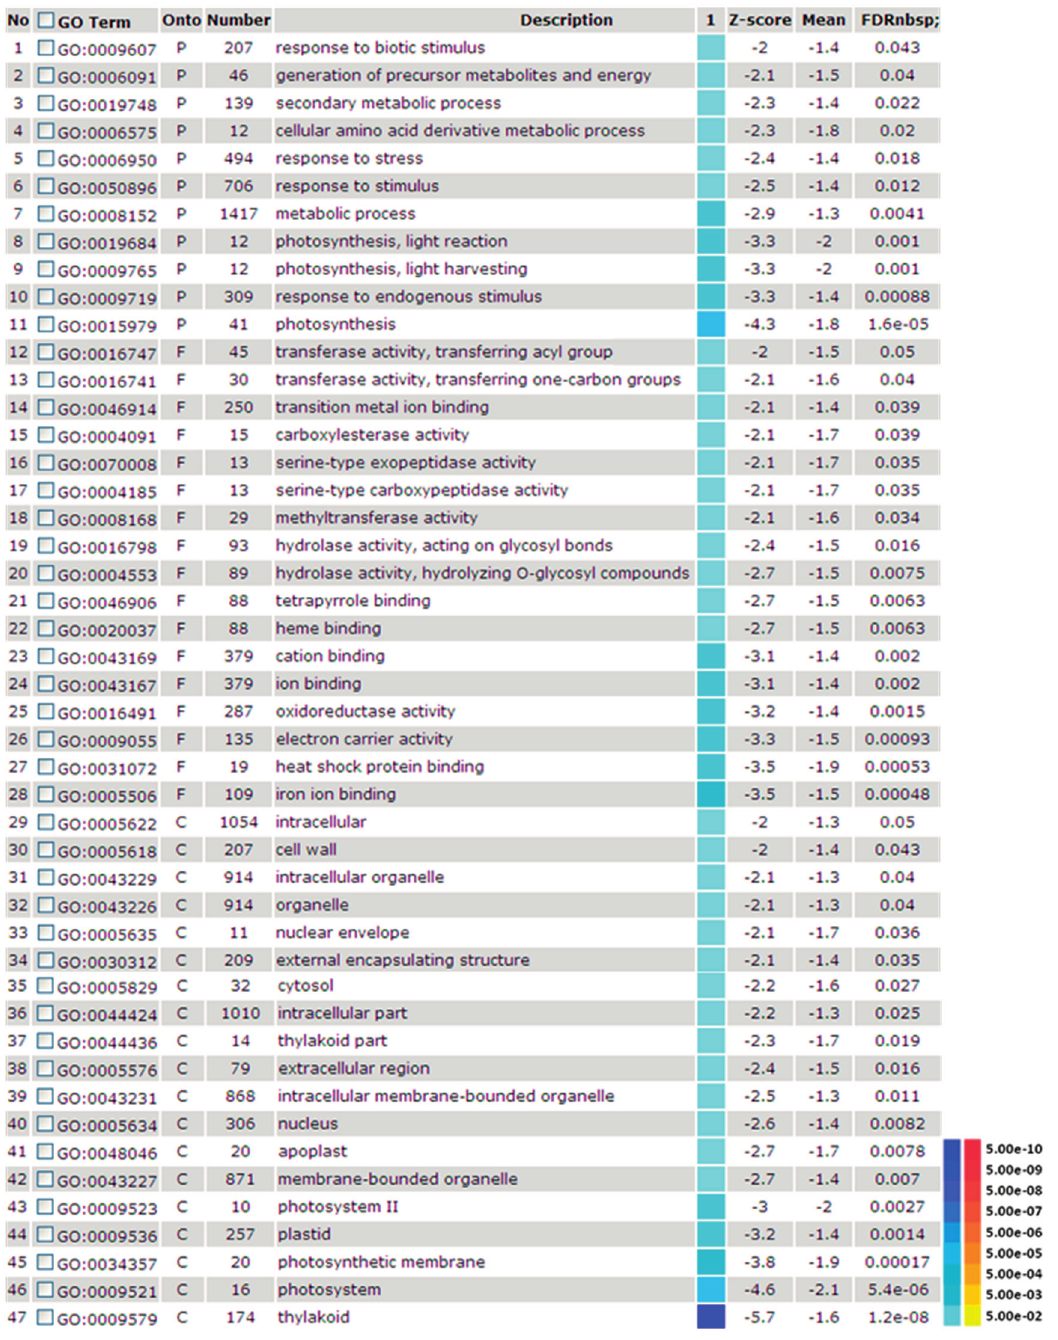
Figure 1. Gene ontology (GO) analysis of the down-regulated differentially expressed genes of rice in response to cold treatment. This figure shows a colorful model of the PAGE analysis of gene expression data under the cold treatment after 72 h. The information includes the following: GO terms, (including 3 GO categories: biological process (P), molecular function (F) and cellular component (C)), number of annotated genes for each GO term, GO description, a simple colorful model in which the red color system indicates up-regulation and blue color indicates down-regulation, and different statistical parameters such as z-scores, means and adjusted P values (FDR) in the different rice